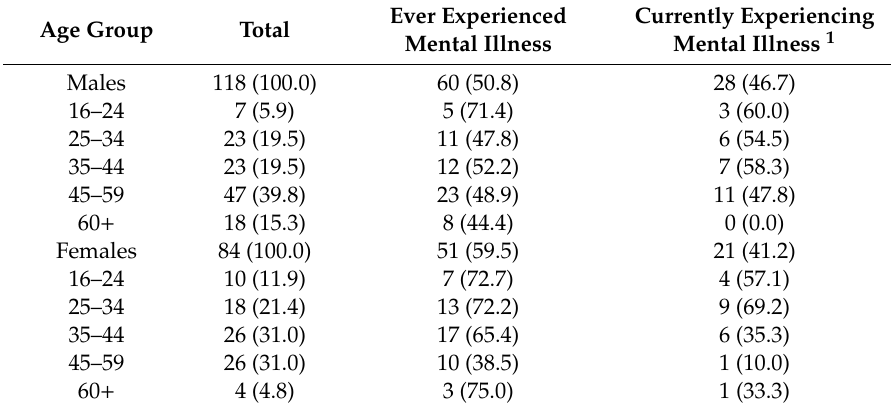
Table 3. Age-related experience of mental illness ( n and %).